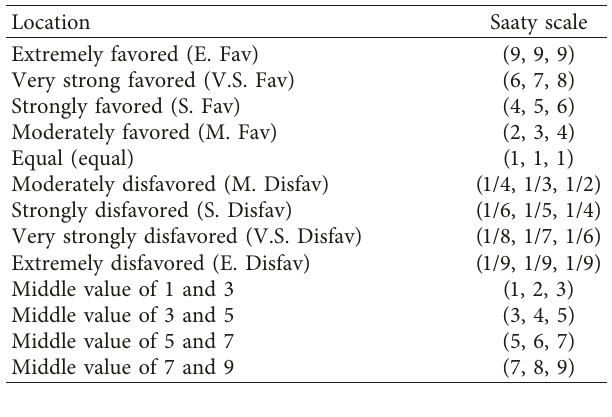
Figure 1: Triangular fuzzy number with α -cut